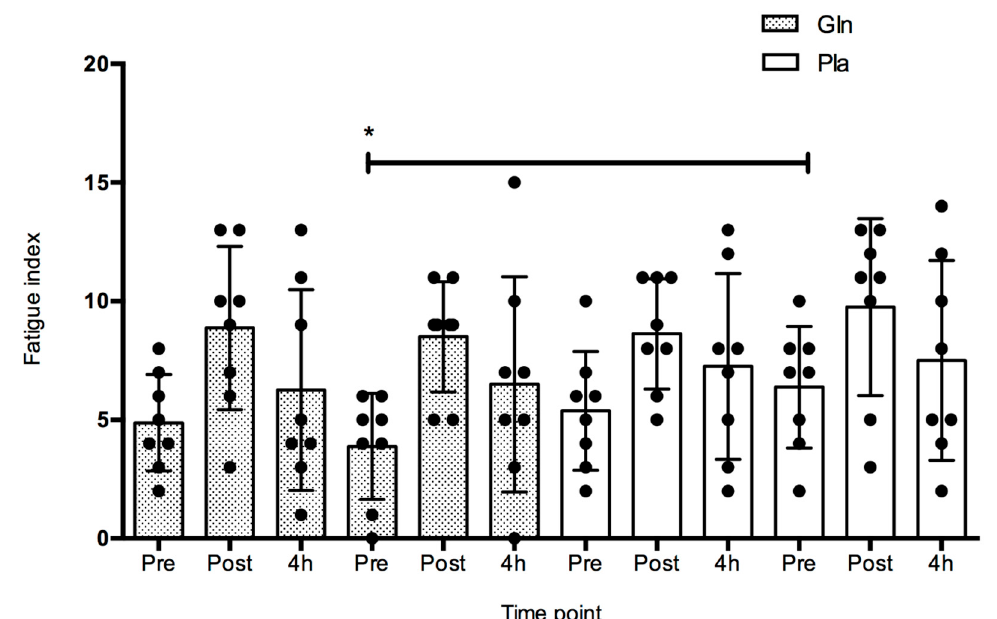
Figure 3. Samn–Perelli Fatigue Index. Subjects felt more fatigued in the Pla trial vs. the Gln during Ex 2 pre (Ex 2 pre = prior to the second day of exercise when participants had ingested glutamine). * p < 0.05 significance compared to the same time point in the Pla trial. Data are mean ± SD, n = 8. Total body antioxidants: The effects of glutamine on total body antioxidants are shown in Figure 4. Total body antioxidants were significantly increased at 4 h post on Day 1, as well as post and 4 h post on Day 2 in the Gln trial compared to the baseline ( p < 0.05). Values did not increase in the Pla trial ( p > 0.05).